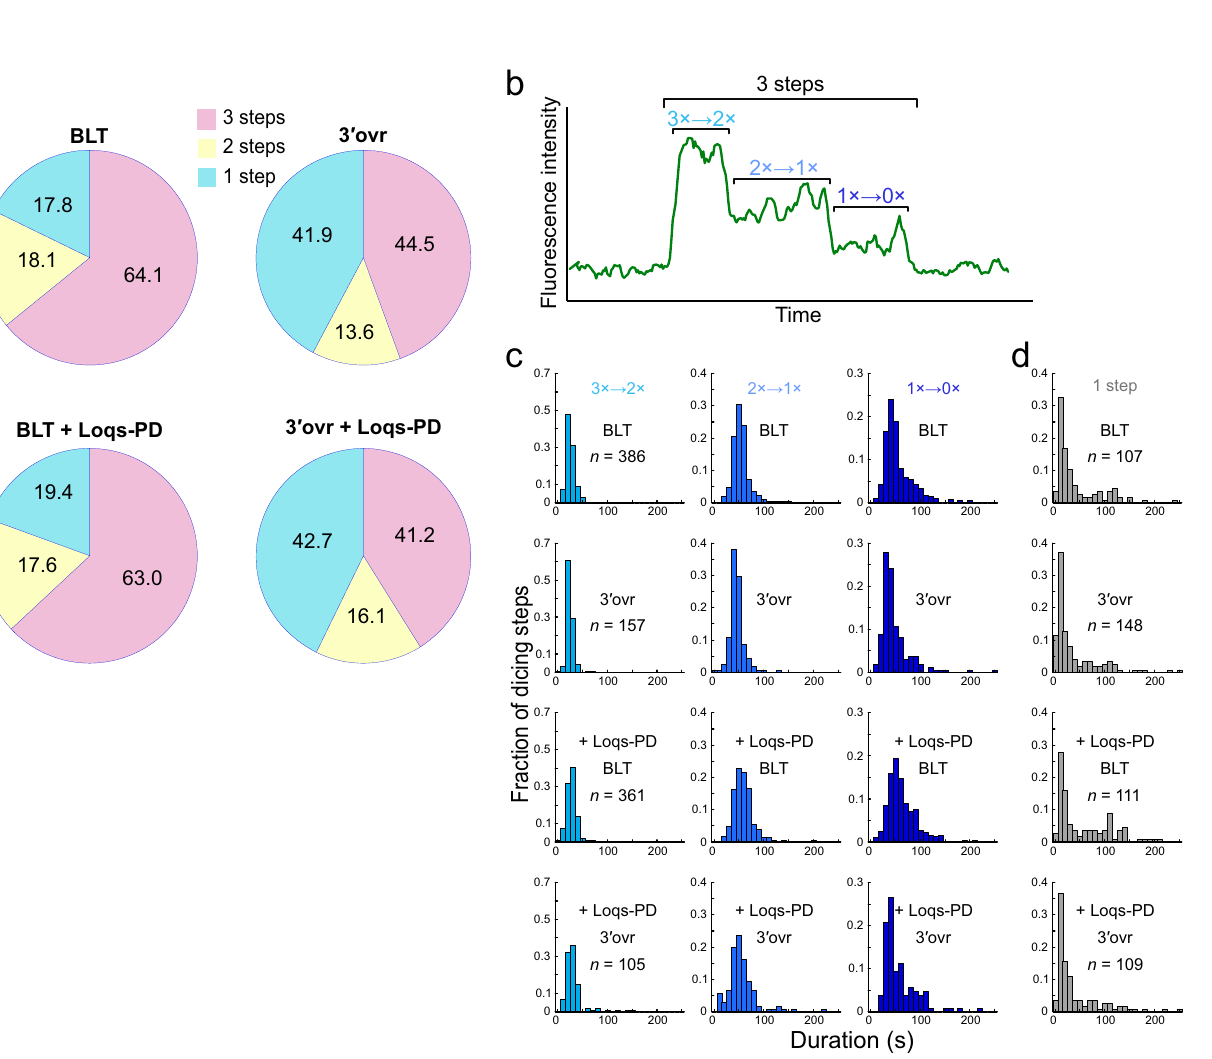
Fig. 3 Characterization of single-molecule events with Dcr-2 tethered on the glass. a Pie-charts showing the proportions of the “ 3-steps ” , “ 2-steps ” , and “ 1-step ” events. b Representative trace of the “ 3-steps ” event. The de fi nition of 3× → 2×, 2× → 1×, and 1× → 0× is indicated. c Dwell time histograms of the 3× → 2×, 2× → 1×, and 1× → 0× steps in the “ 3-steps ” events. d Dwell time histograms of the “ 1-step ” events. The dsRNA terminal structure or Loqs-PD did not change the dwell time distributions for all the steps. Source data are provided as a Source Data fi